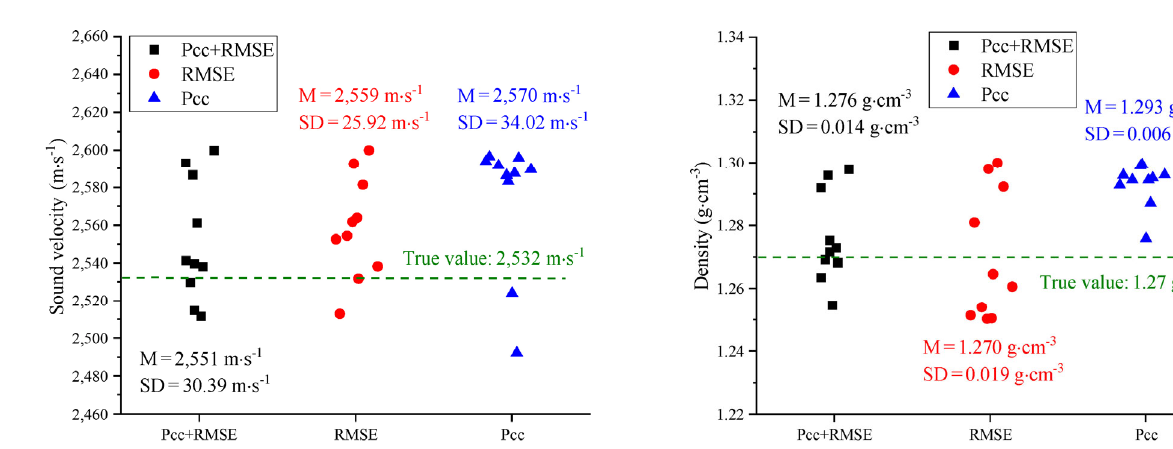
Fig. 8 Effect of different objective functions on the inversion results of acoustic velocity.